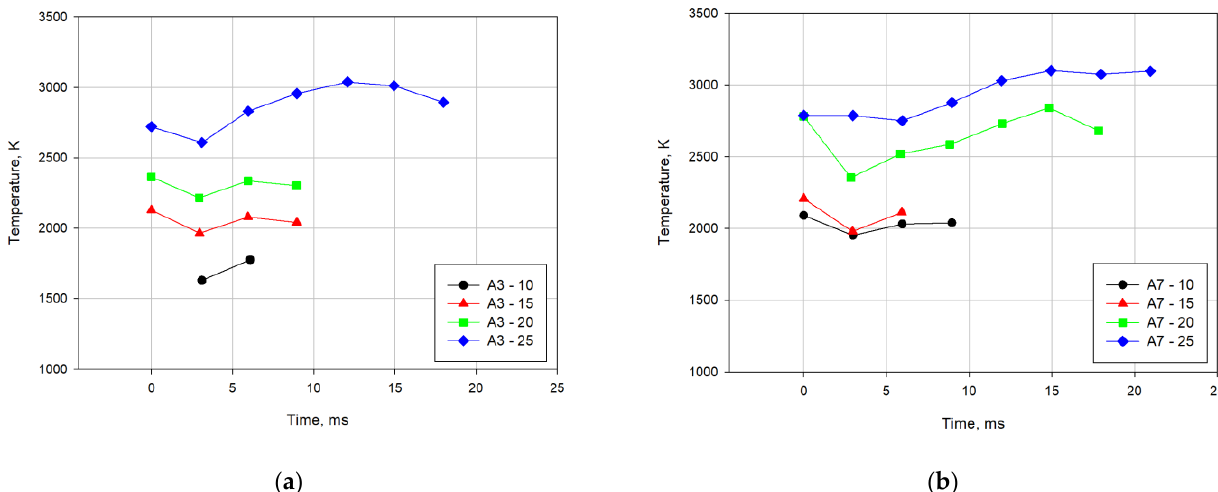
Figure 10. Changes of temperatures of the detonation products clouds for the explosives containing ( a ) 3% Al f ; ( b ) 7% Al f . ( a ) 3% Al f ; ( b ) 7% Al f